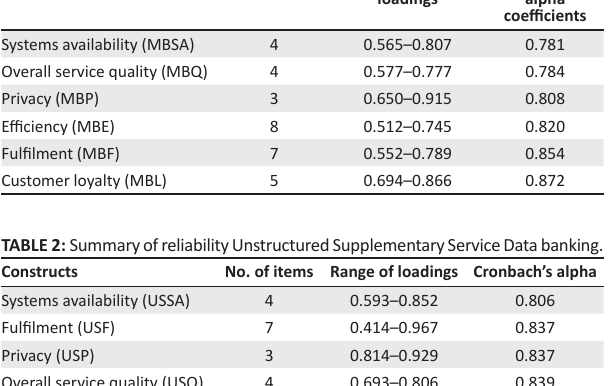
FIGURE 3: Mode of mobile banking. TABLE 1: Validity and reliability of a mobile banking app. Constructs